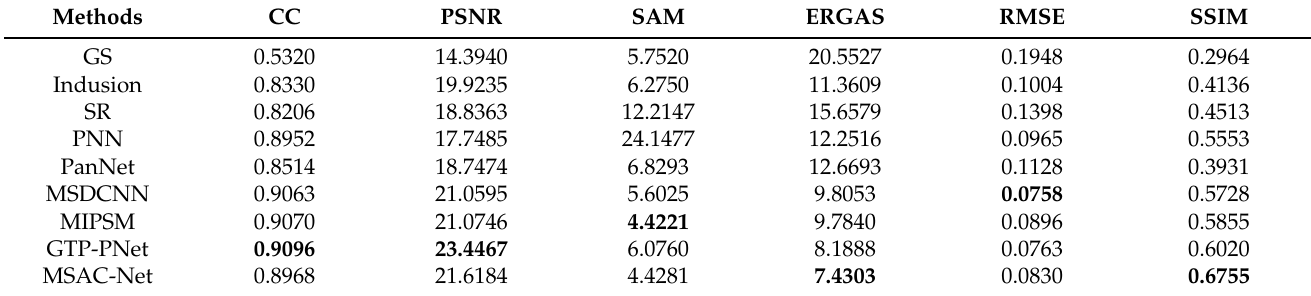
Table 7. Quality metrics of the different methods on the simulated IKONOS image.